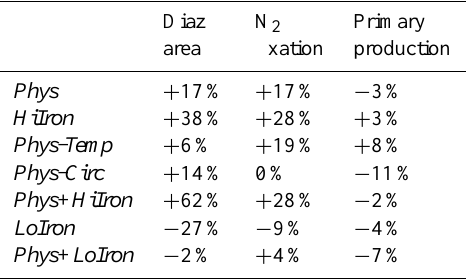
Table 2. Differences between global integrated results of sensitivity experiments to Control .